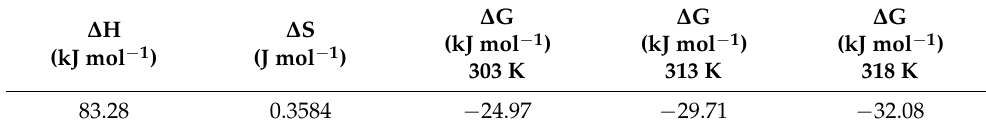
Table 4. Thermodynamic parameters for arsenate adsorption on MgO-IBC composite. ∆